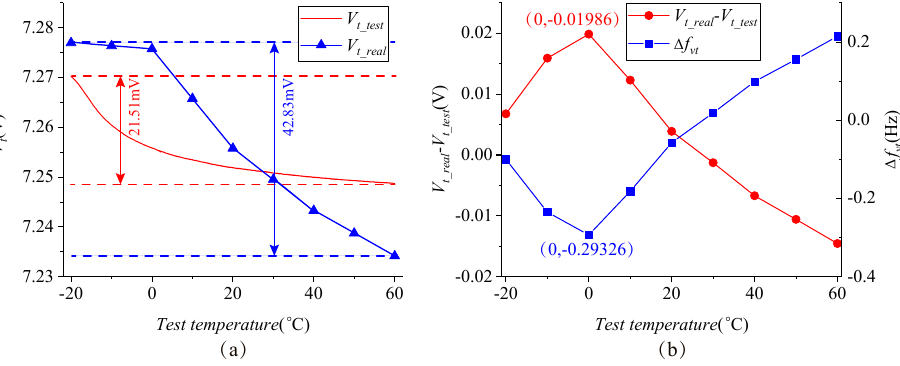
Figure 14. Wide temperature range test curves: ( a ) The variation of frequency tuning voltage, ( b ) The variations of V t _ real − V t _ test and ∆ f ν t